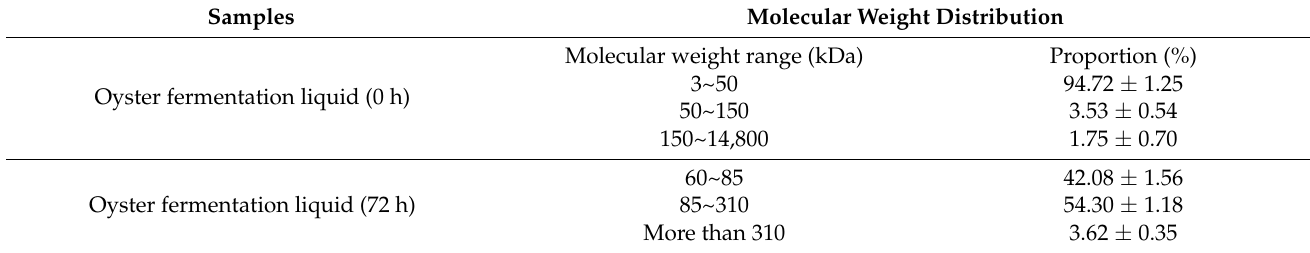
Table 2. Proportion changes of oyster protein hydrolysate with different molecular weights in oyster fermentation